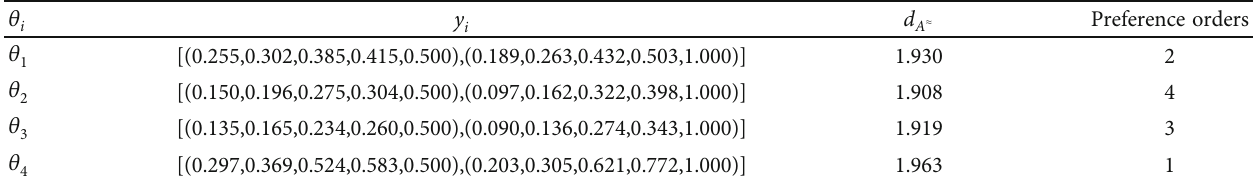
Table 7: Preference orders computed by full multi fi cation form (MULTI-MOORA) algorithm.